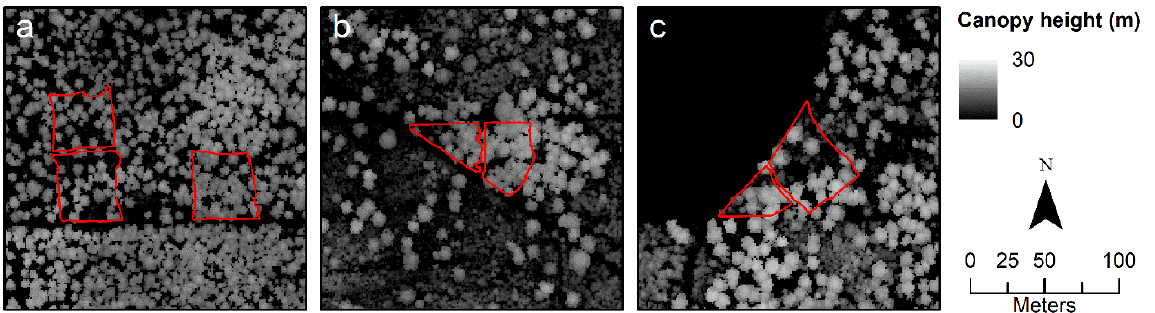
Figure 3. Canopy height model (CHM) derived from ALS at 1-m resolution, depicting overviews of burn units ( a ) 16D1, 16D5, and 16D6, ( b ) 24A Triangle and 24A Main, and ( c ) 24B Triangle and 24B Main.